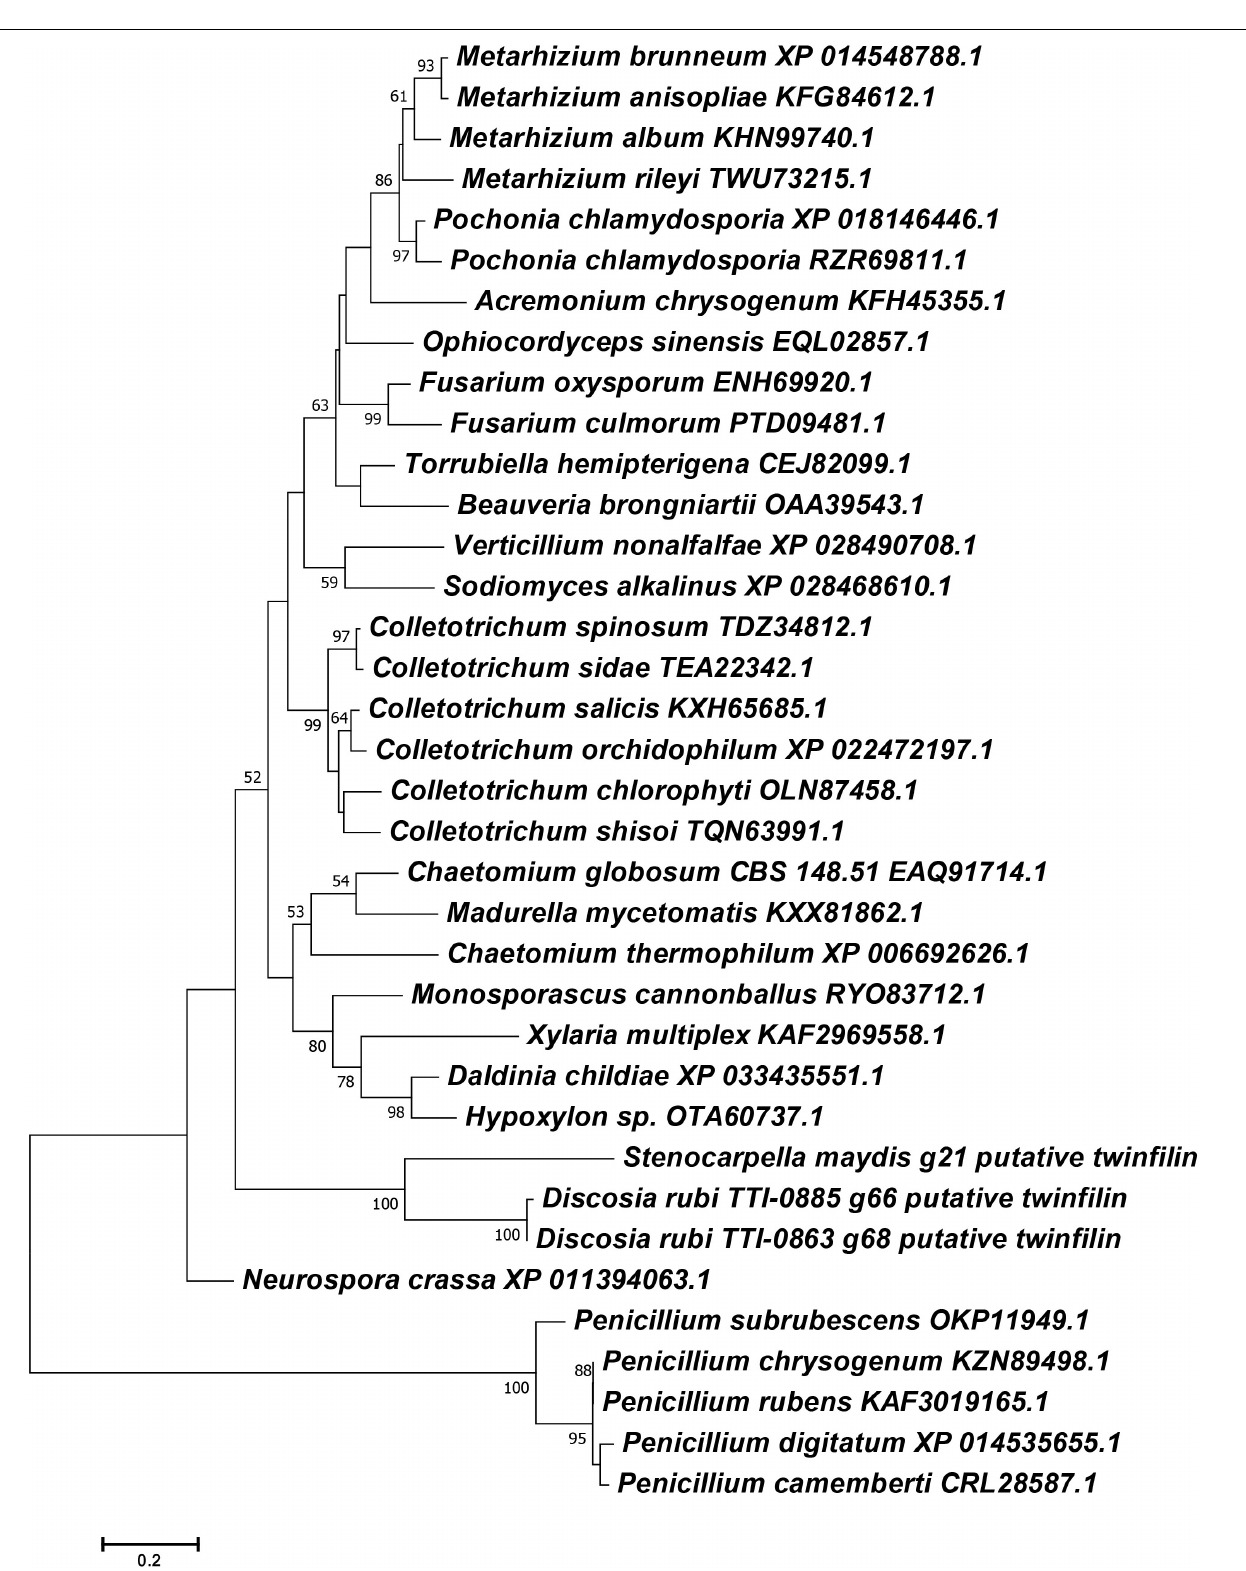
FIGURE 5 | Phylogenetic reconstruction of selected Ascomycete twinfilin-1 protein sequences. Phylogeny was inferred by the ML method implemented in MEGA 7.0 under a LG + G model. Bootstrap supports > 50% from 1000 replicates per run are labeled on branch nodes. Penicillium species were designated as the outgroup.